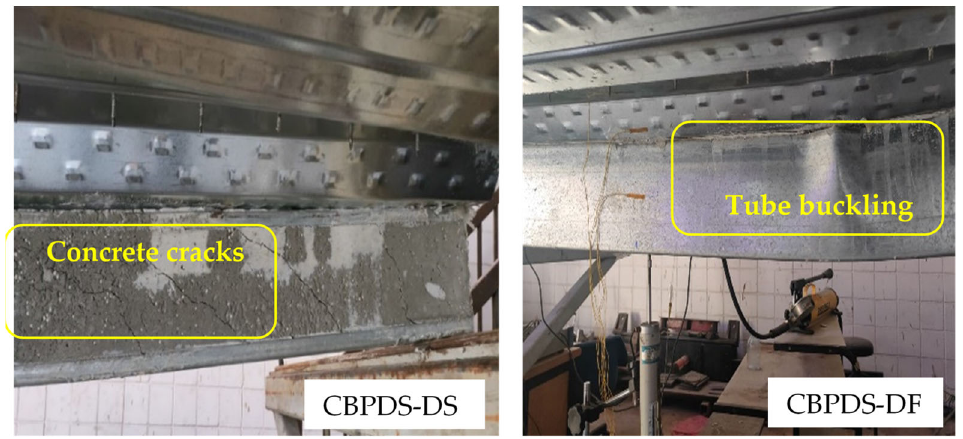
Figure 10. Buckling and concrete cracks for beam in CBPDS specimens.